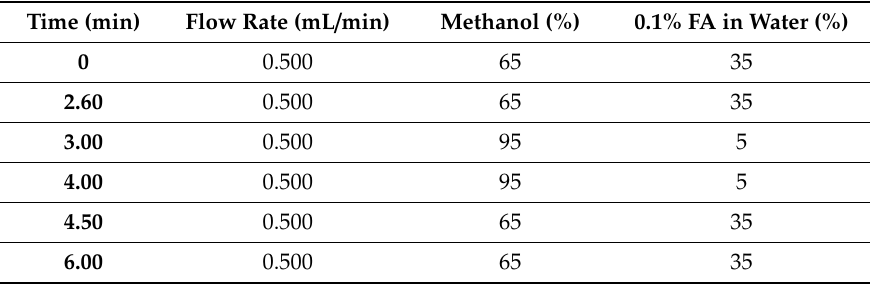
Table 2. LC parameters for the analysis of ritonavir in plasma samples.